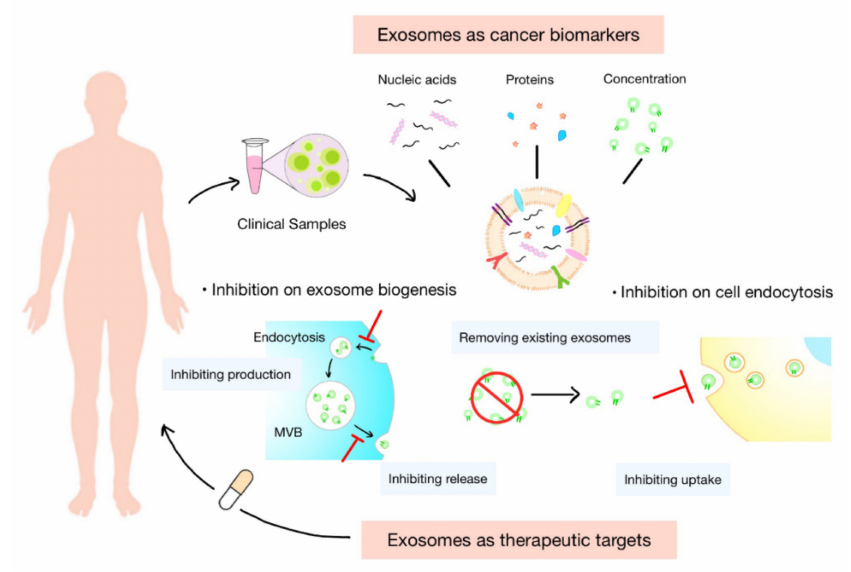
Figure 3. Clinical potential of exosomes. Exosomes normally serve as biomarkers or therapeutic targets in clinical settings. The concentration of exosomes and cargoes carried by them, such as nucleic acids and proteins, are potential diagnostic biomarkers of tumor and prognostic indicators of treatments. Inhibiting the biogenesis, release, or uptake of exosomes and removing the circulating cancer exosomes could be novel targets for anticancer